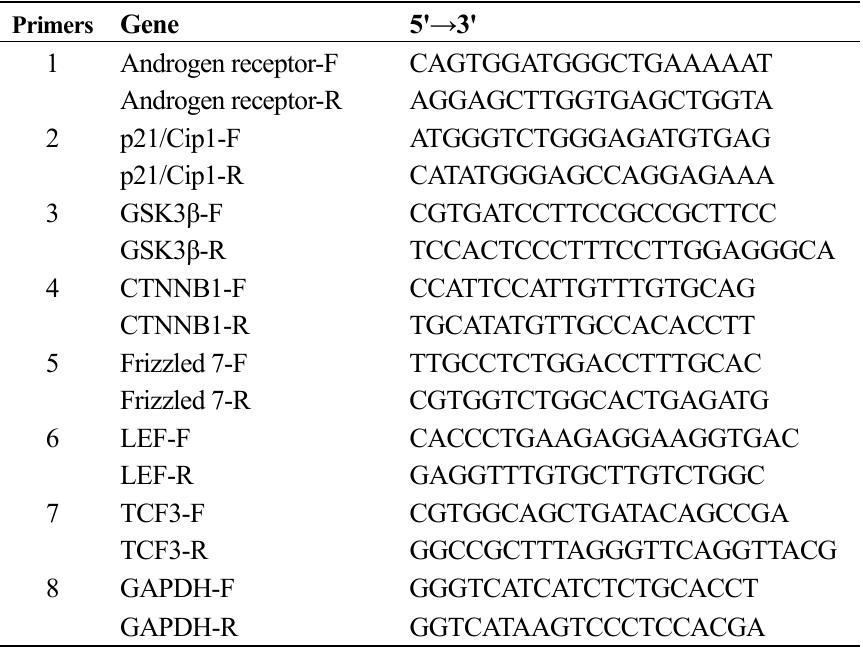
Table 3. Nucleotide sequences of the primers used for quantitative PCR